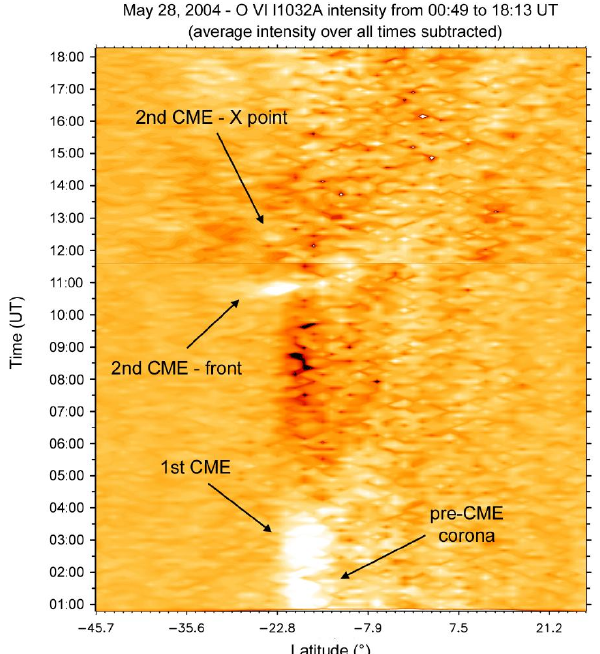
Fig. 3. Distribution of the intensity of the O VI 1032 ˚A line as a function of the heliographic latitude (x-axis) and time (y-axis), derived from UVCS data. At each position along the slit, the inten- sity of the line averaged over the whole observing time, has been subtracted from individual intensities. The CME front reaching the UVCS slit at ≈ 10:40UT and the reconnection point reaching the UVCS slit at ≈ 12:20UT show up in the enhanced OVI 1032 bright- ness and are indicated by